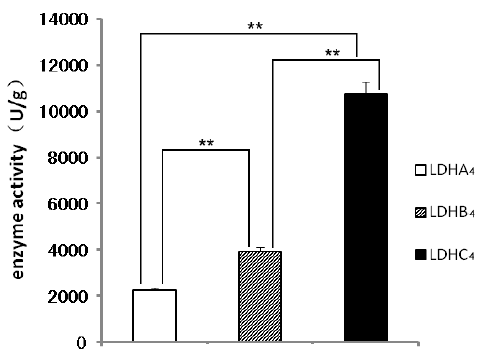
Figure 4. The enzyme activities of LDH-A 4 , LDH-B 4 and LDH-C 4 . The enzyme activity of LDH-A 4 , LDH-B 4 , and LDH-C 4 was 2241 ± 9.3 U/g protein, 3918 ± 37.9 U/g protein, 10741 ± 80.9 U/g protein, each sample size was 5, ** p < 0.01. The enzyme activity of LDH-C 4 was significantly higher that of LDH-A 4 and LDH-B 4 ( p < 0.01).